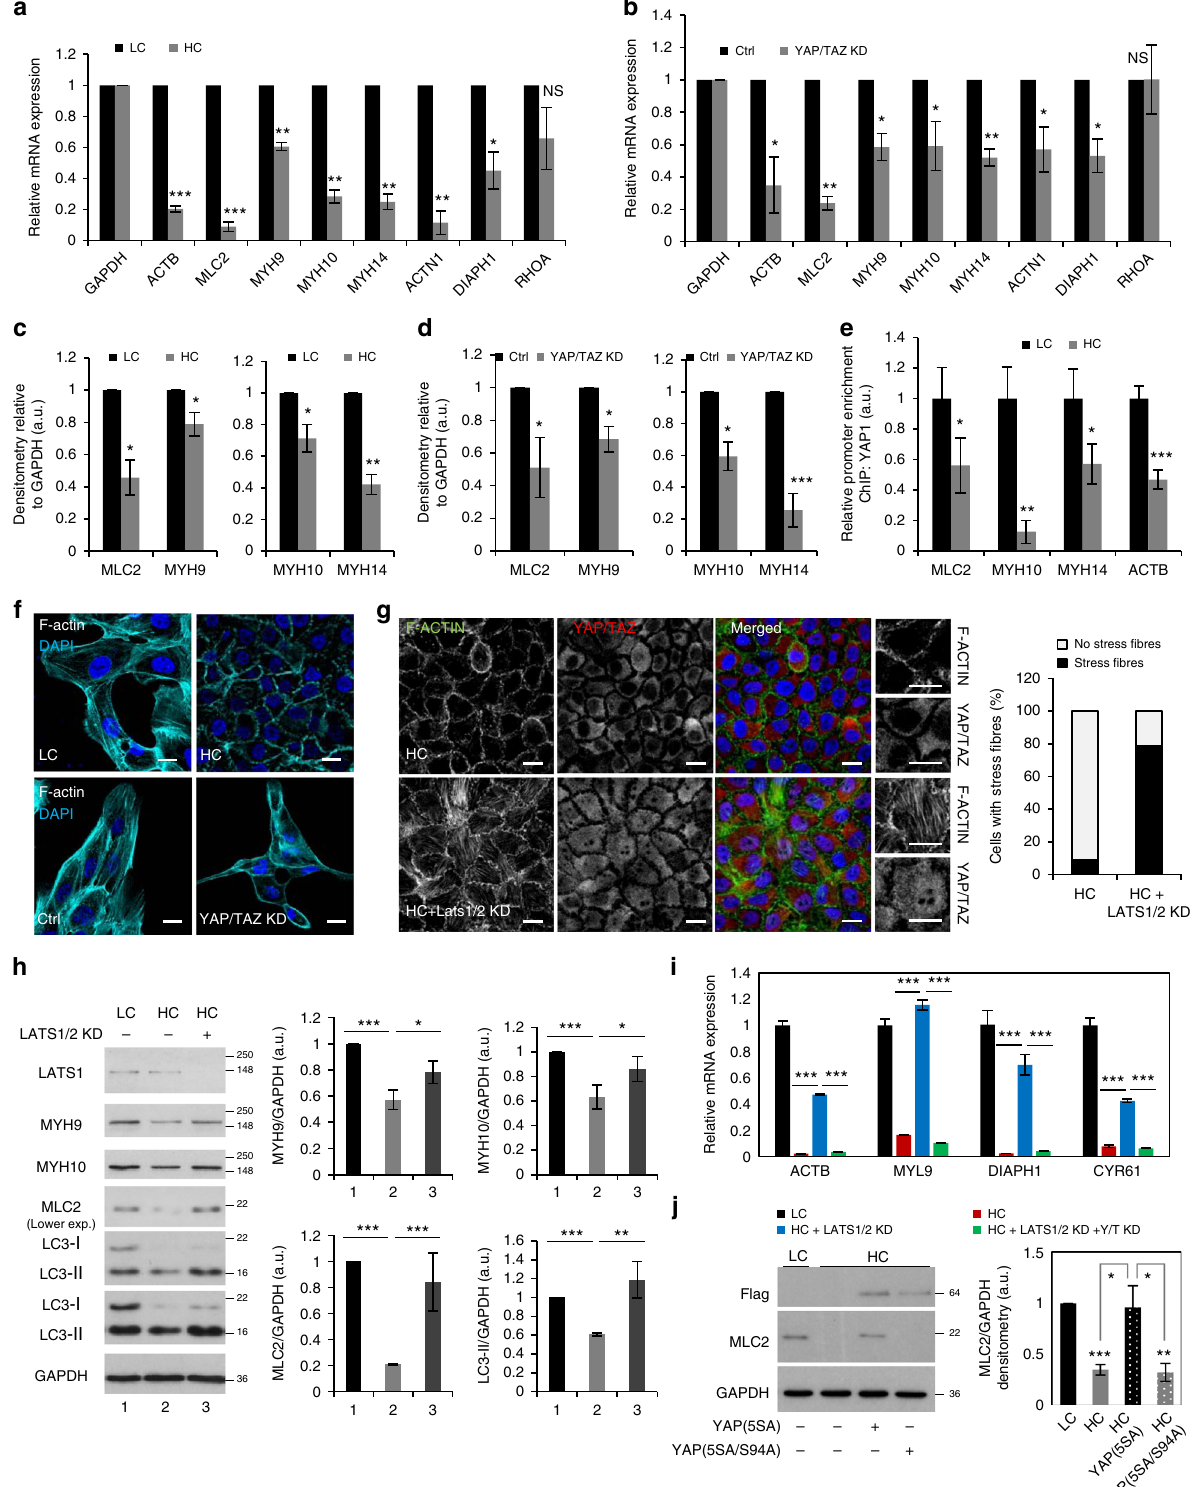
Fig. 2e – f, and increased phospho-ULK1(S555) (AMPK substrate) — Supplementary Fig. 2g, as previously reported 25 – 28 , and